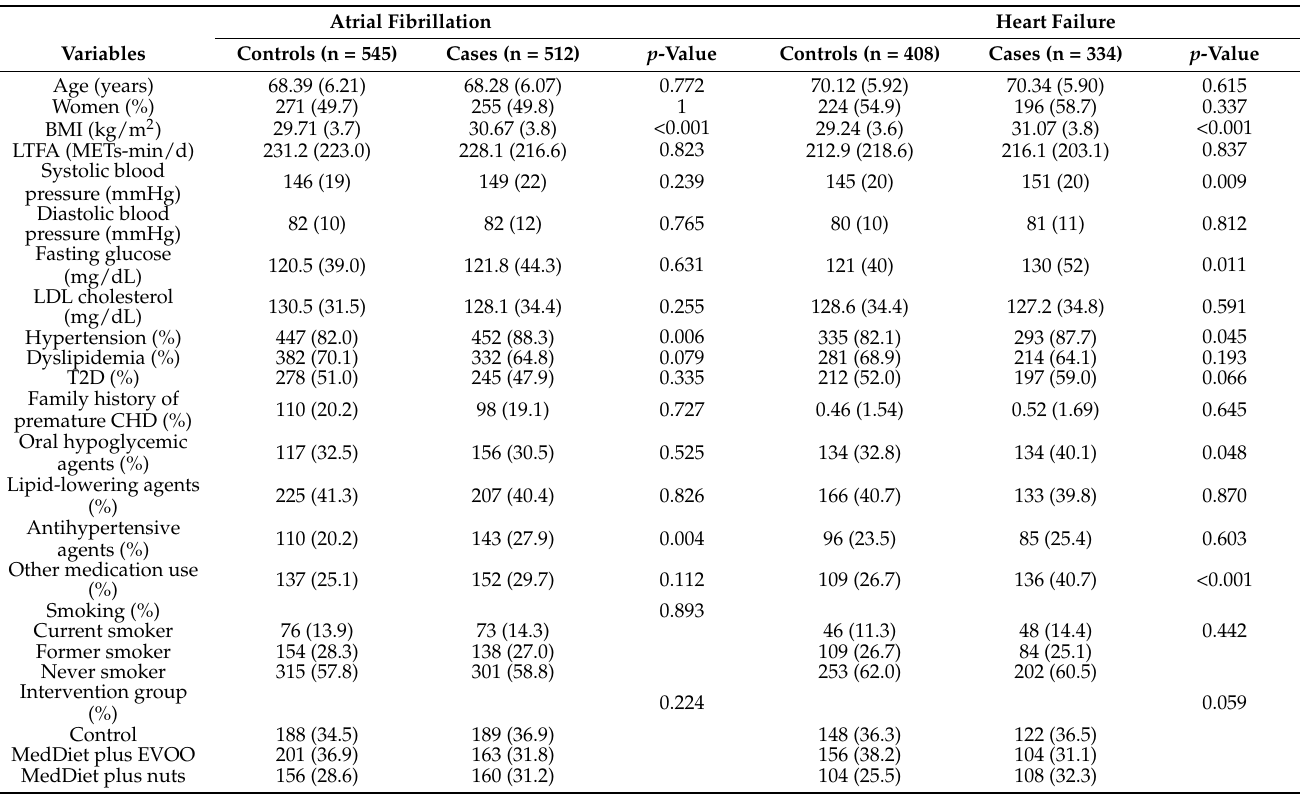
Table 1. Baseline participant characteristics of heart failure (HF) and atrial fibrillation (AF) incident cases and controls.